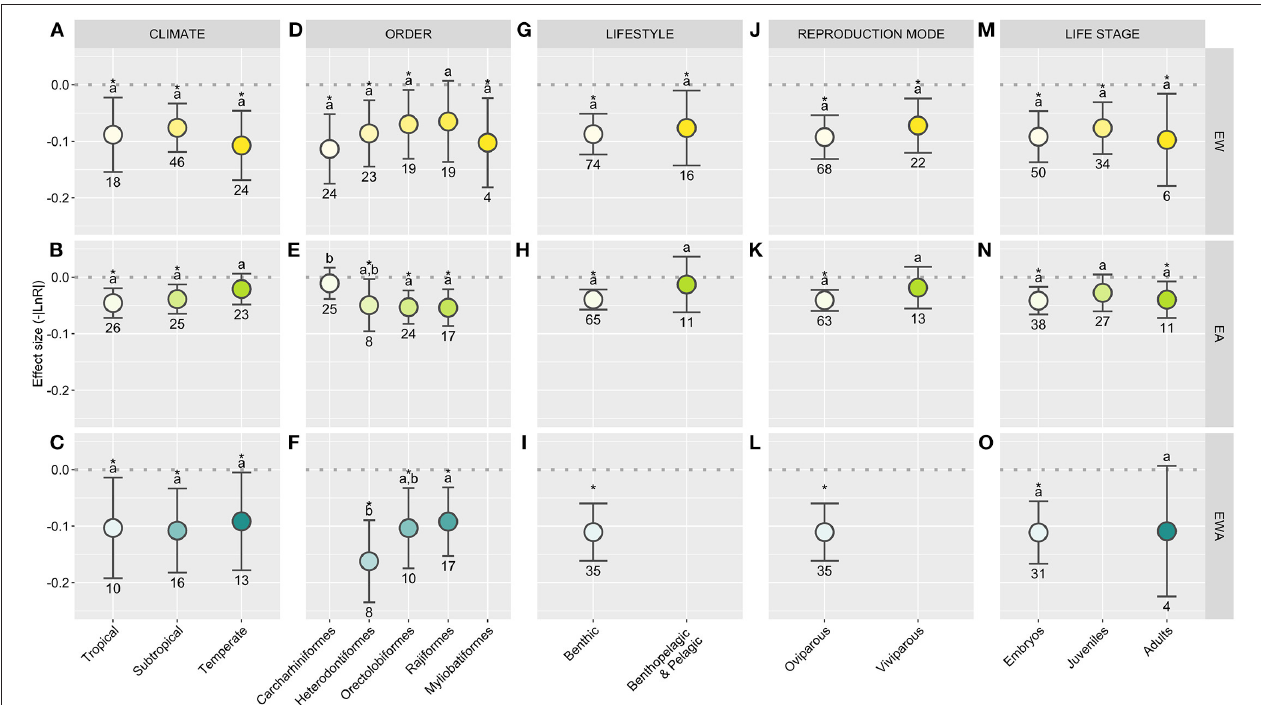
FIGURE 3 | Elasmobranch response to each experimental treatment [warming (EW); acidification (EA); and warming + acidification (EWA)] depending on the attribute [climate (A–C) , order (D–F) , lifestyle (G–I) , reproduction mode (J–L) , life stage (M–O) ] of the model species used and standardized according to the stressor ratio (SR) implemented in each study. Effect sizes represent the absolute value of the response ratio (-|LnR|) and 95% confidence intervals (CI). The dashed line ( R = 0) represents the threshold used to test the null hypothesis, with overlapping CI indicating the lack of treatment effect; asterisks indicate a significant effect. Different lowercase letters showcase differences between treatments; numbers indicate sample sizes (number of control-treatment contrasts). Statistical results are detailed in Supplementary Table 2